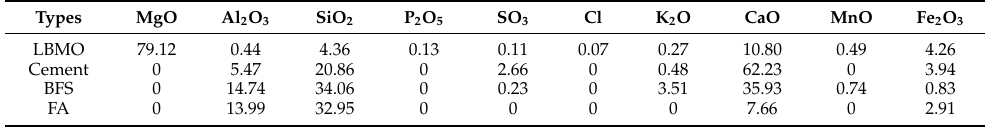
Table 1. Mass percentage content of each component of the lightly burned magnesia expansion agent